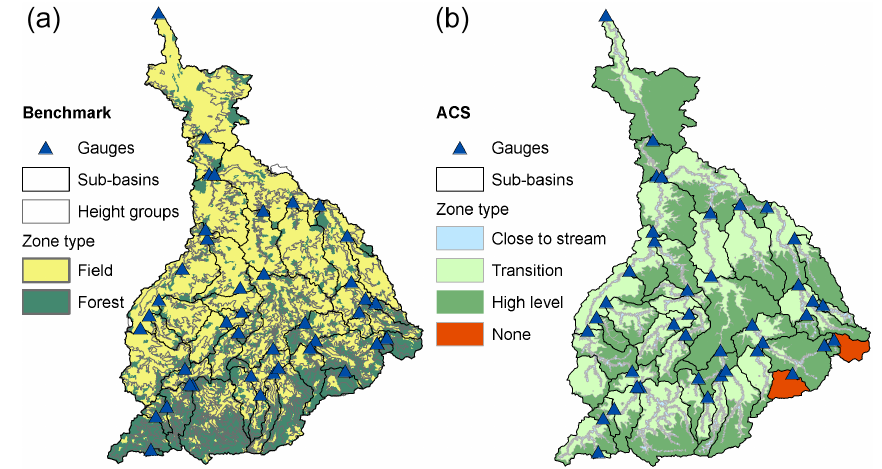
Figure 15. Spatial structures for the HBV 96 model: (a) ACS basins and zones; (b) gauging network, land use, and heights. Table 4. Parameter quantities.